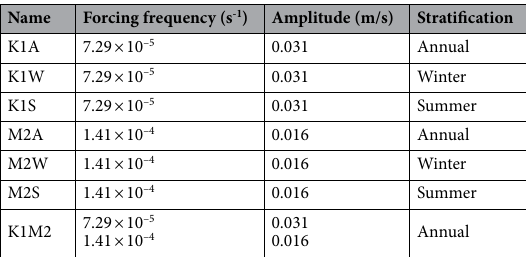
Table 2. Parameters in the sensitivity experiments.